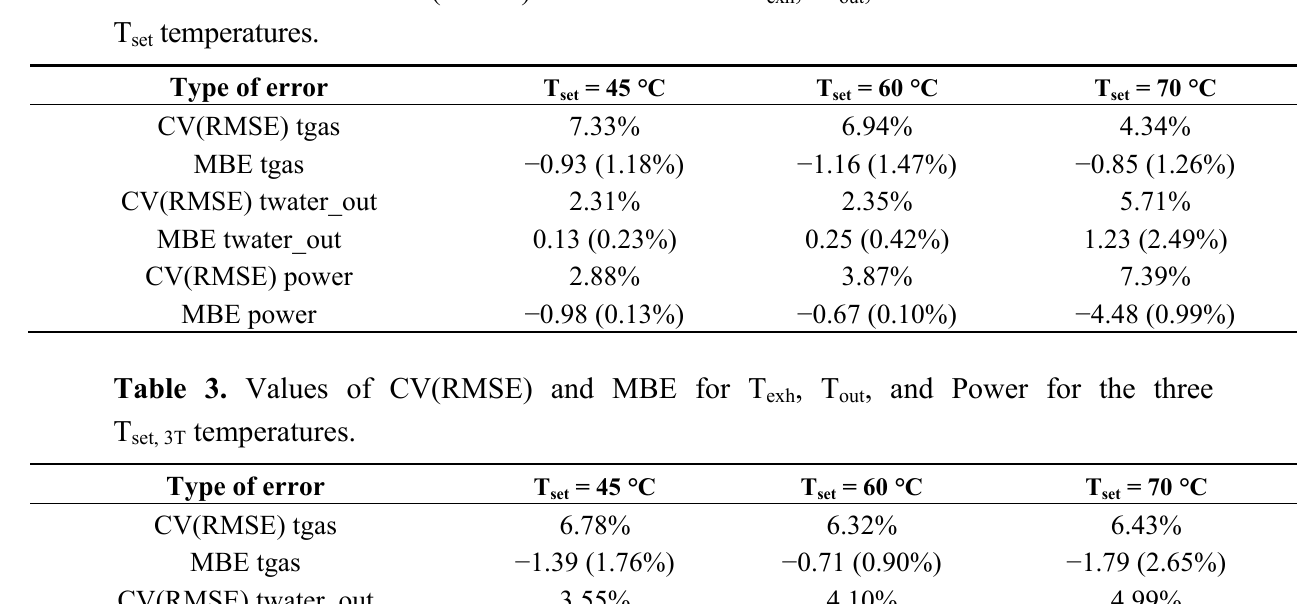
, T , and Power for the three exh out